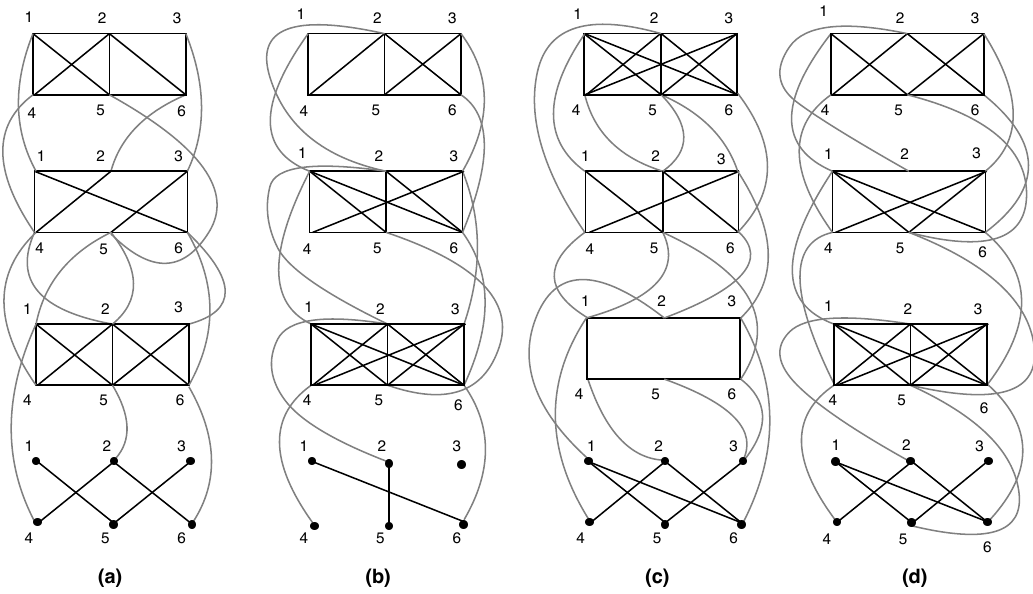
Figure 1. ( a ) LG 24,4 . ( b ) LLG 23,4 . ( c ) SLG 24,4 . ( d ) SLLG 24,4 . Layer 1 is the topmost and layer 4 is the 6 6 6 6 bottommost. Vertices have labels from { 1,2,3,4,5,6 } within a given layer. Intra-layer edge is a thick line whereas inter-layer edge is thinner. ( a – d ) are CLG s as well. ( a , b ) are not a SLG s (( a ): layer 4 has two components {1,3,5} and {2,4,6}. ( b ): layer 4 has three components {1,6}, {2,5} and {4}; vertex 3 does not exist, only a placeholder is